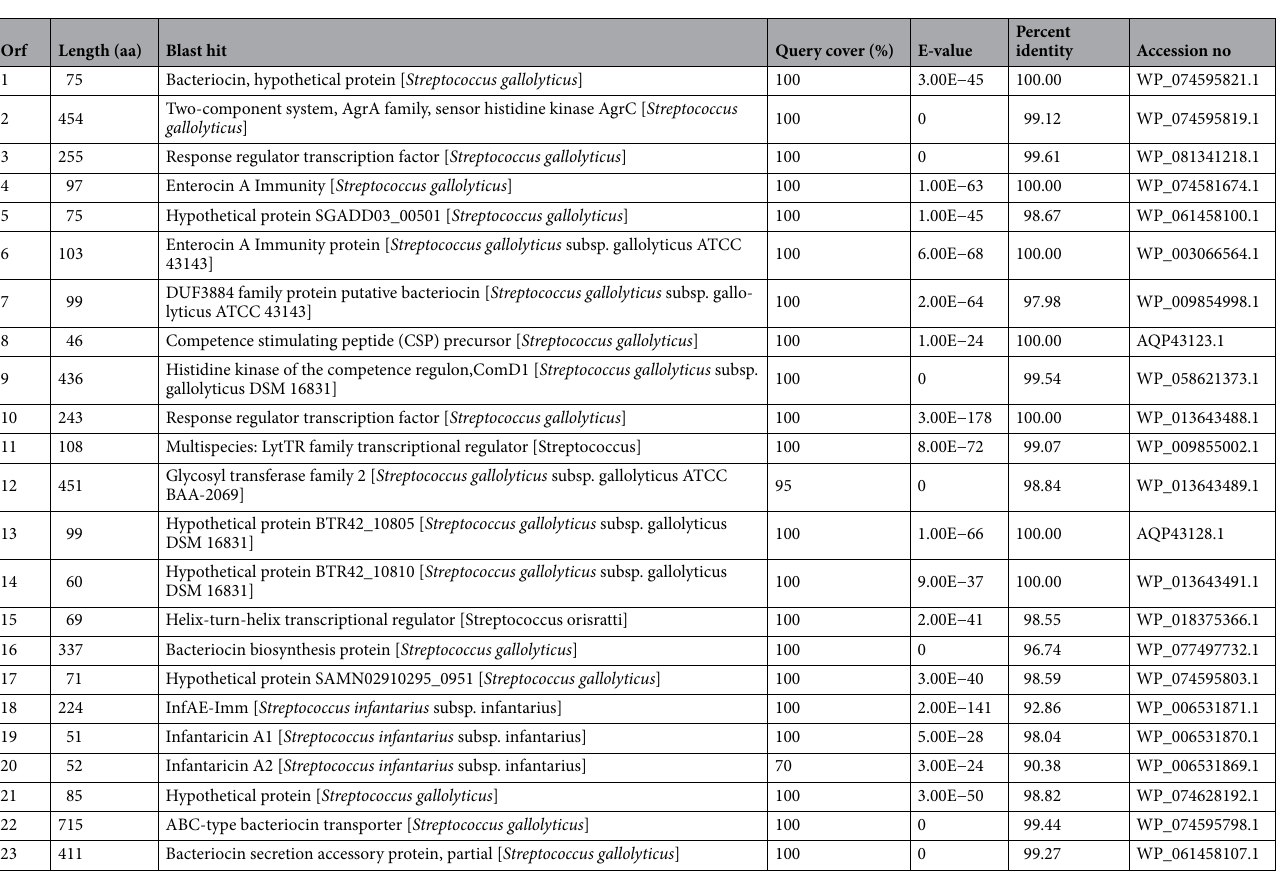
Table 2. In silico analysis of the predicted function of each gene involved in bacteriocin production.